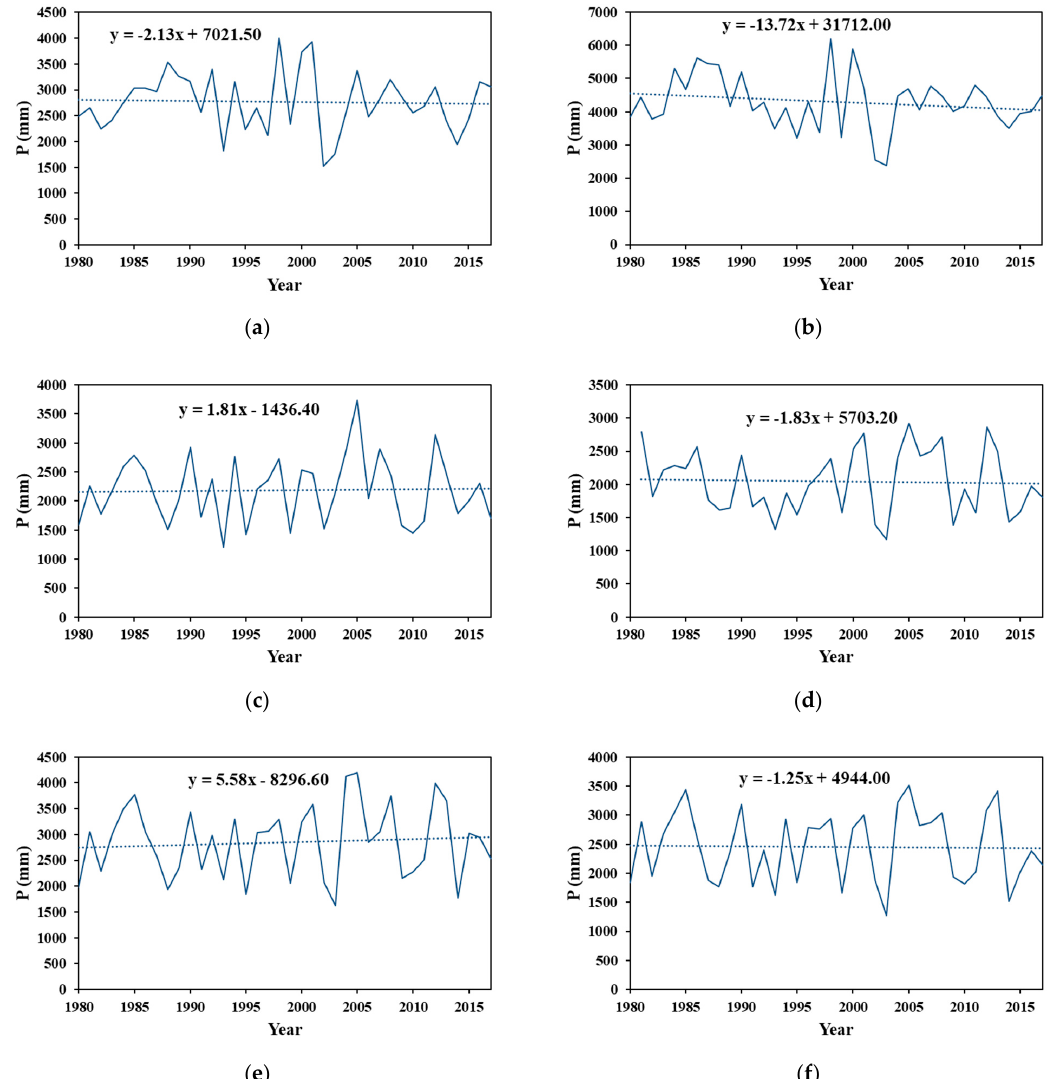
Figure 2. The trend of annual precipitation in northern Taiwan during 1980~2017. ( a ) Lanyang River Basin. ( b ) Keelung River Basin. ( c ) Dahan River Basin. ( d ) Fengshan River Basin. ( e ) Youluo River Basin. ( f ) Shangping River Basin.